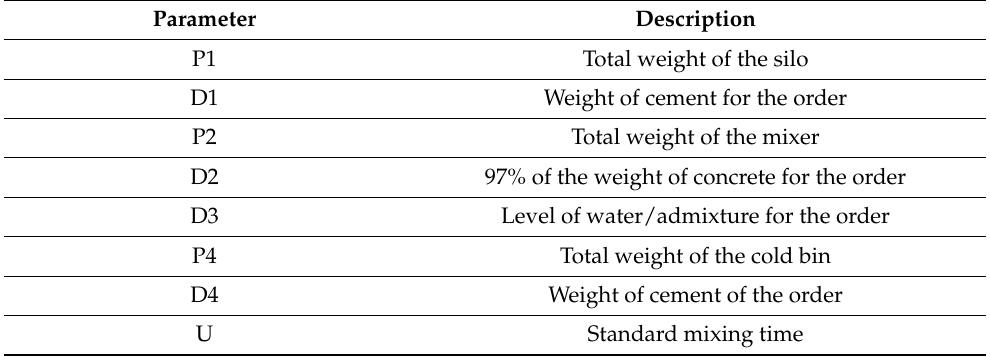
Table 5. Parameter Notations Used in Flow Chart of DT